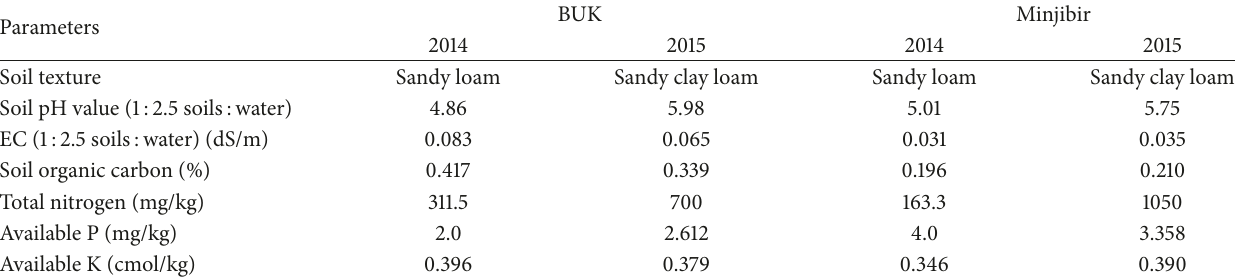
Table 1: Physical and chemical properties of the soils (0–20 cm depth) at the experimental